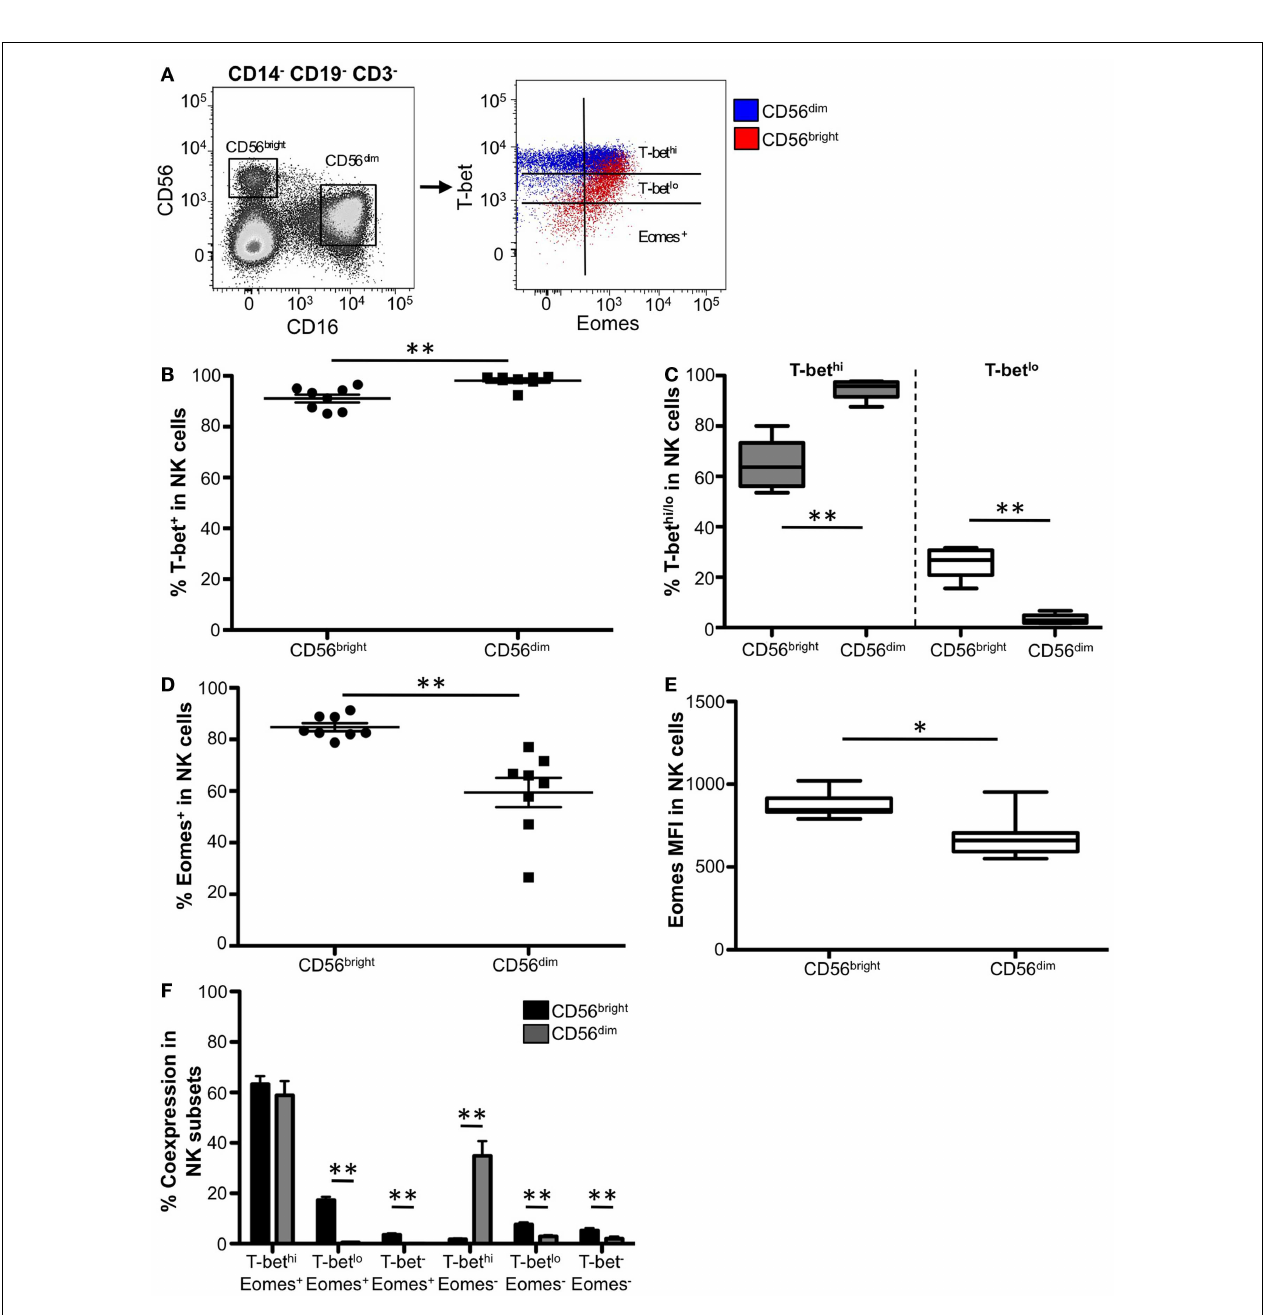
shown. Each symbol represents and individual donor. (C) Box and whisker graphical representation of the frequency ofT-bet hi (gray) and T-bet lo (white) expression for each NK population is shown.The box and whisker graphs display 25–75% (box), 10–90% (whisker), and the median value (line). (D) The frequency of Eomes-expressing NK cells is shown. (E) Eomes MFI from Eomes + cells from each NK population is shown. (F) Frequency ofT-bet and Eomes co-expression within each subset. * p <